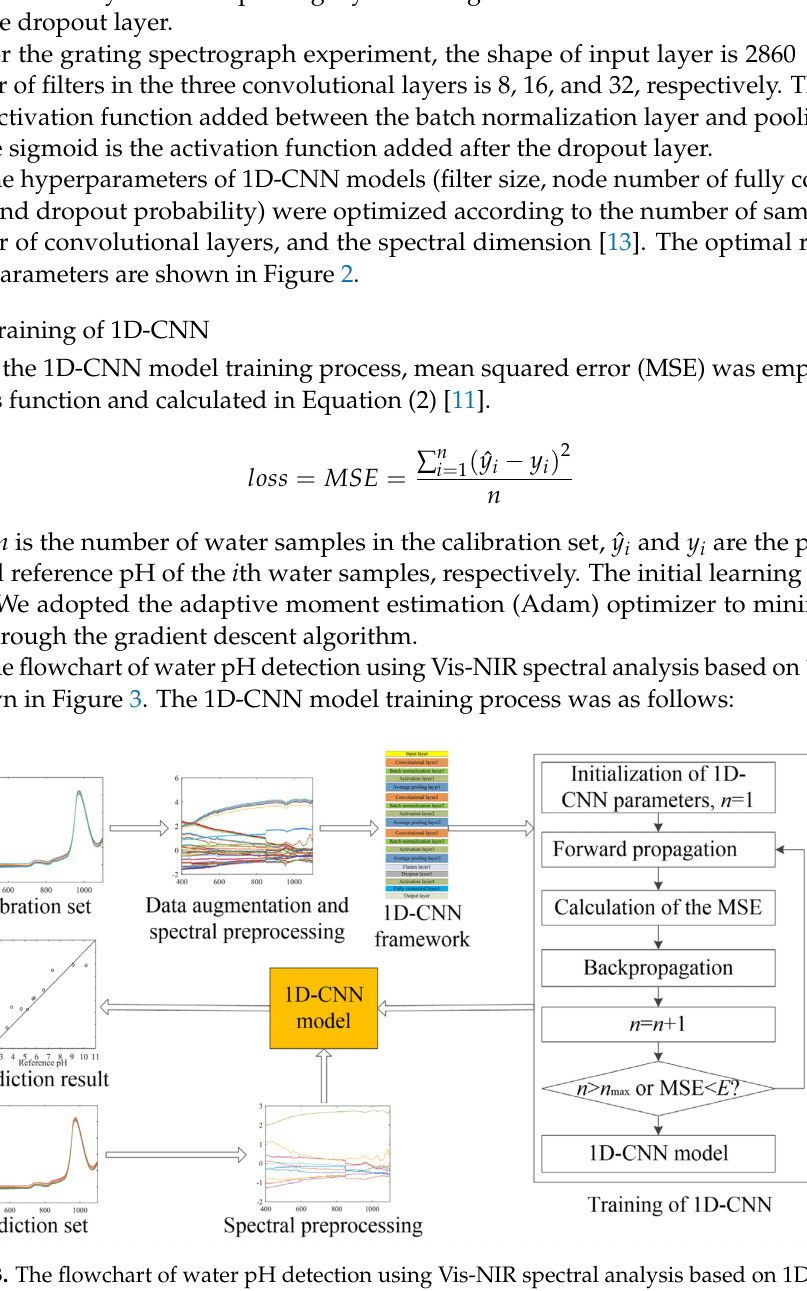
Figure 3. The flowchart of water pH detection using Vis-NIR spectral analysis based on 1D-CNN. In this figure, n is the training epochs and E is the expected value of